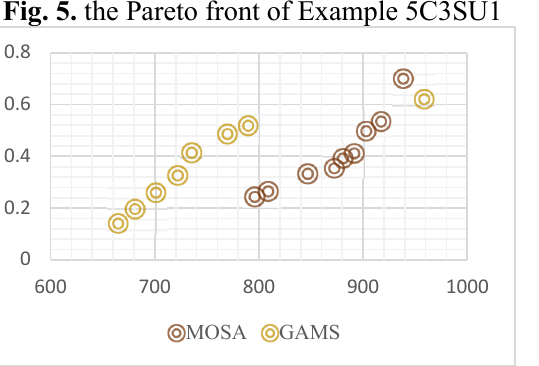
Fig. 5. the Pareto front of Example 5C3SU1 Fig. 6. the Pareto front of Example 5C3SU2